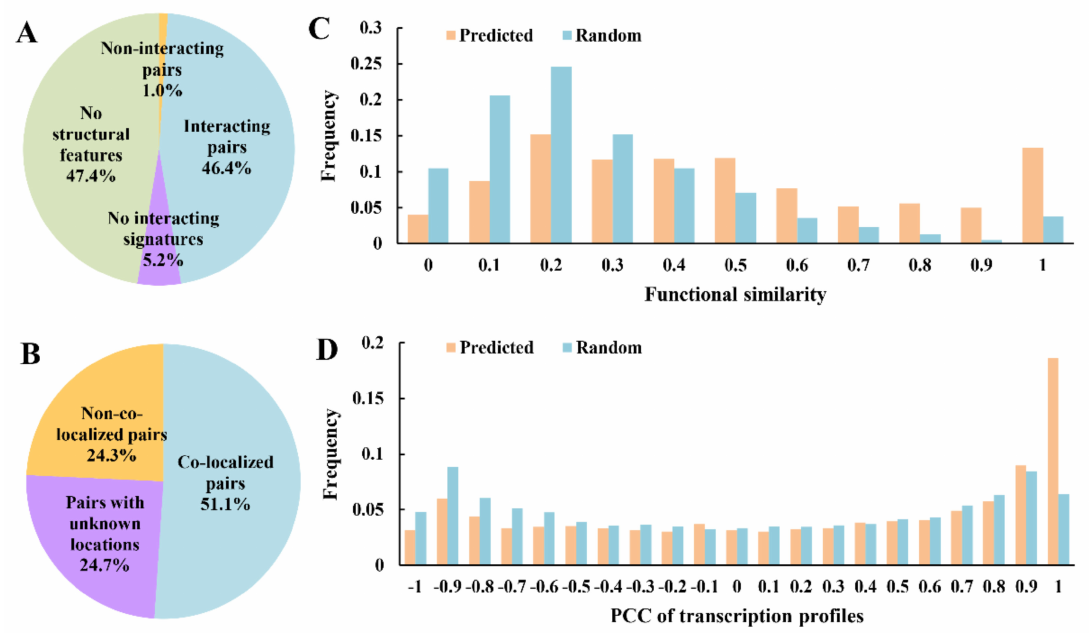
Figure 2. Validation of the B. diazoefficiens USDA110 protein interactome. ( A ) Validated by iLoop server. “Interacting pairs” represents the directly confirmed PPIs; “Non-interacting pairs” represents the directly non-confirmed PPIs; “No structural features” represents that no structural features (loop or domain) could be assigned to either one or both proteins; “No interaction signatures” represents that the pair of proteins had structural features but no interacting features. ( B ) Validated by subcellular co-localization. “Co-localized pairs” represents that the two interacting proteins were co-localized; “Non- co-localized pairs” represents that the two interacting proteins were not co-localized; “Pairs with unknown locations” represents that at least one protein in an interacting protein pair had no subcellular location information. ( C ) The difference of distribution of functional similarity between the reconstructed network and the randomized network of the same topology. Higher frequencies appear in the reconstructed network than the random network when functional similarity becomes larger. ( D ) The distribution difference of PCC of gene transcription profiles between the reconstructed network and the randomized network of the same topology. Higher frequencies appear in the reconstructed network than the random network when PCC of transcription profiles becomes